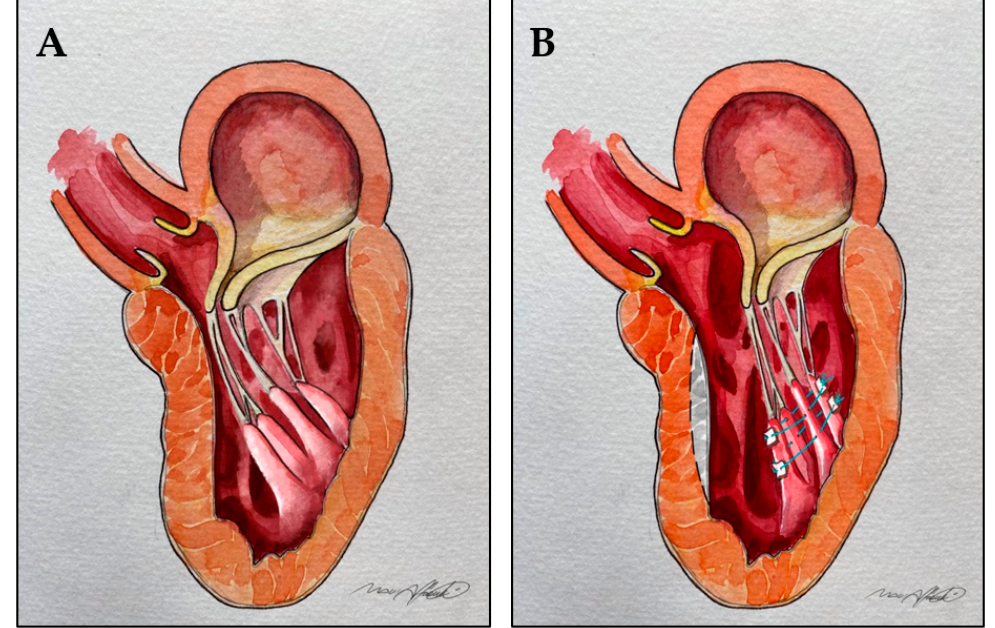
Figure 5. Reorientation of hypermobile bifid papillary muscles. ( A ): Bifid hypermobile papillary muscles determining LVOT obstruction. ( B ): Pledgetted mattress sutures are used to reposition the mobile papillary muscles towards the posterior wall of the left ventricle, thus pulling them away from the LVOT. Dotted line and gray area: shallow septal myectomy.